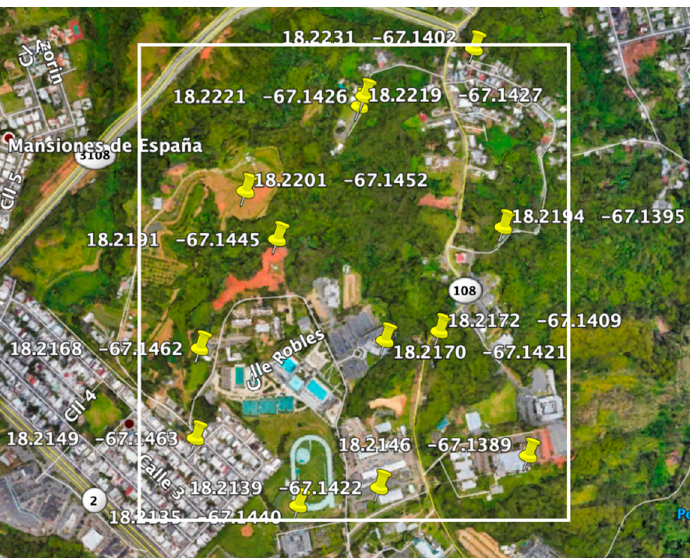
Figure 1. Location of the GOES imagery pixel footprint. Soil samples were collected from the area on 1 October, 13 October, 7 November, and 5 December 2015, and 7 June, 27 June, and 18 August 2016. Yellow pins show locations of soil samples. White line represents the approximate limits of the 4 km × 4 km GOES satellite pixel.